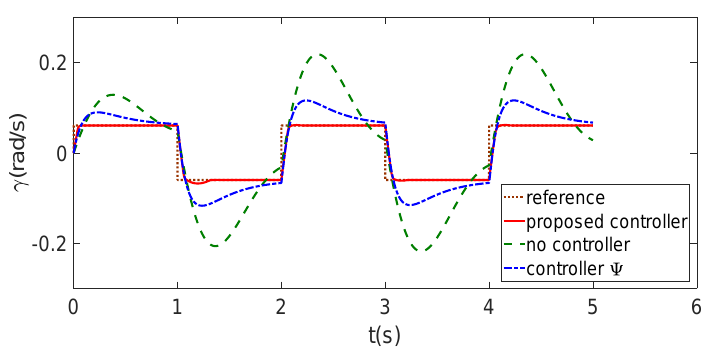
Figure 9. Vehicle yaw